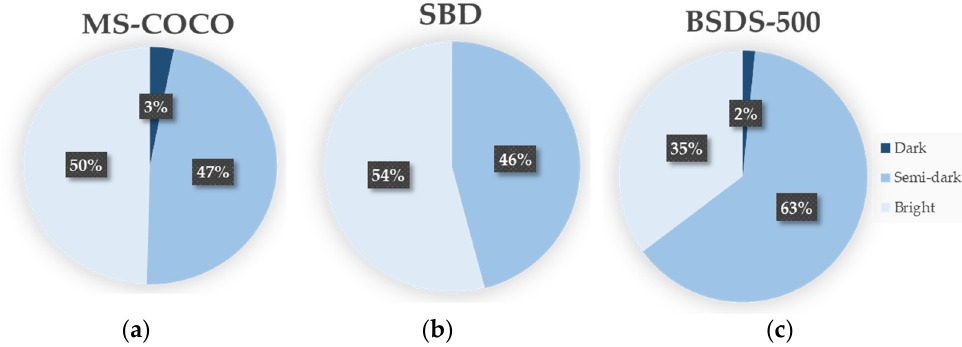
Figure 3. Enhanced Dataset Percentages for Dark, Semi-dark and Bright Images.